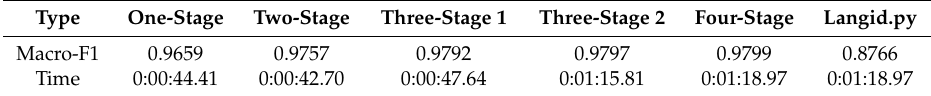
Table 24. Comparison results for different levels of hierarchical LI.